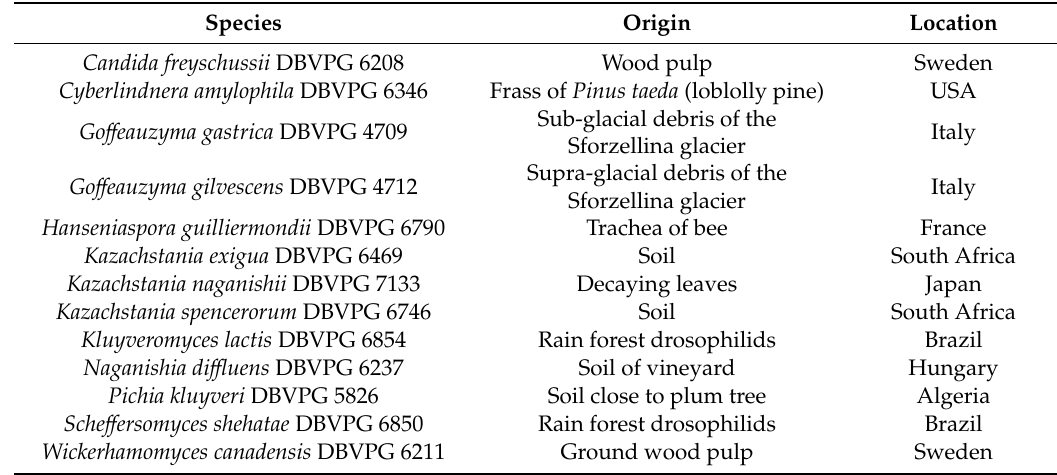
Table 1. Salient information on the Non-Conventional Yeast (NCY) strains used in the present study. Species Origin Location Candida freyschussii DBVPG 6208 Wood pulp Sweden Cyberlindnera amylophila DBVPG 6346 Frass of Pinus taeda (loblolly pine) USA Sub-glacial debris of the Go ff eauzyma gastrica DBVPG 4709 Italy Sforzellina glacier Supra-glacial debris of the Go ff eauzyma gilvescens DBVPG 4712 Italy Sforzellina glacier Hanseniaspora guilliermondii DBVPG 6790 Trachea of bee France Kazachstania exigua DBVPG 6469 Soil South Africa Kazachstania naganishii DBVPG 7133 Decaying leaves Japan Kazachstania spencerorum DBVPG 6746 Soil South Africa Kluyveromyces lactis DBVPG 6854 Rain forest drosophilids Brazil Naganishia di ffl uens DBVPG 6237 Soil of vineyard Hungary Pichia kluyveri DBVPG 5826 Soil close to plum tree Algeria Sche ff ersomyces shehatae DBVPG 6850 Rain forest drosophilids Brazil Wickerhamomyces canadensis DBVPG 6211 Ground wood pulp